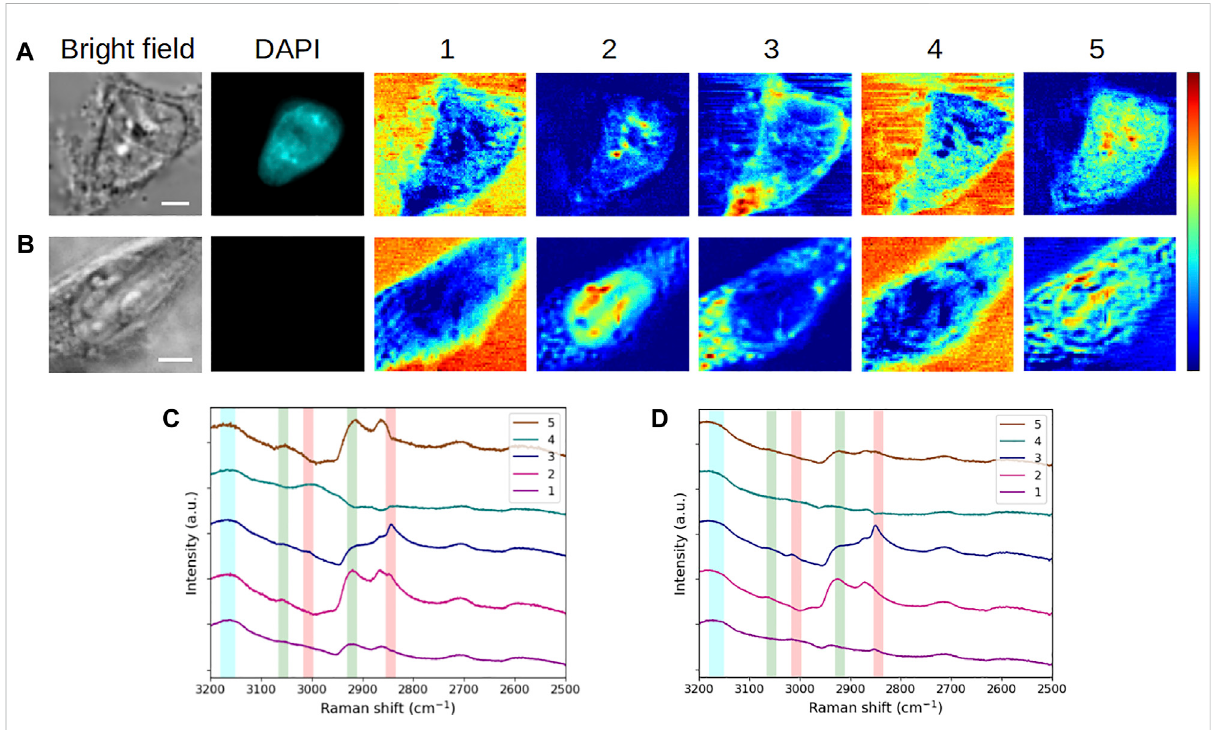
FIGURE 3 Comparative analysis of fi xed (A,C) HEK293 and (B,D) C2C12 cells in interphase (G 1 /S). (A,B) Bright- fi eld and fl uorescence images and concentration maps obtained for the fi ve computed components. The scale bar corresponds to 5 μ m. (C,D) Spectra corresponding to (A,B) , respectively. Vertical bars highlight the presence of lipids (red), proteins (green), and water (blue). After fi xation, the HEK293 cell was stained with